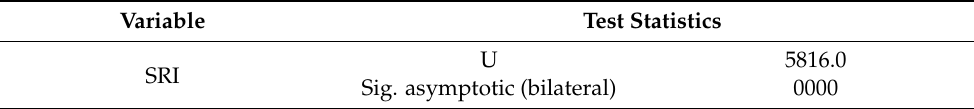
Table 6. Mann–Whitney U test for Hypothesis 1.